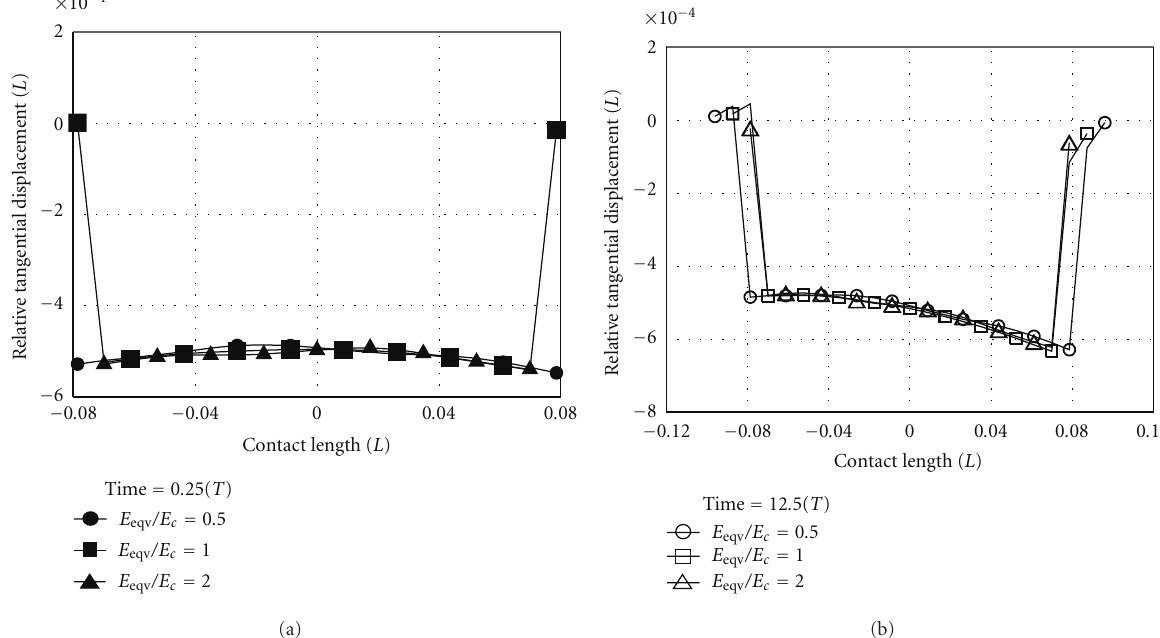
Figure 9: E ff ect of E eqv /E c on the relative tangential displacement distribution.